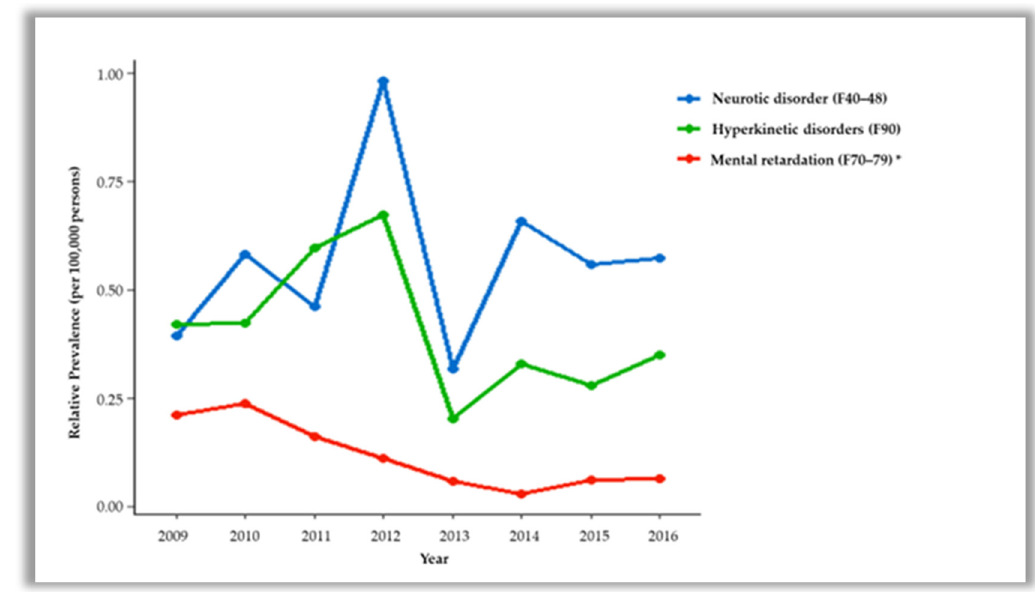
Figure 1. Distribution of mental disorders in male patients by year ( p value of slope, * <0.05).